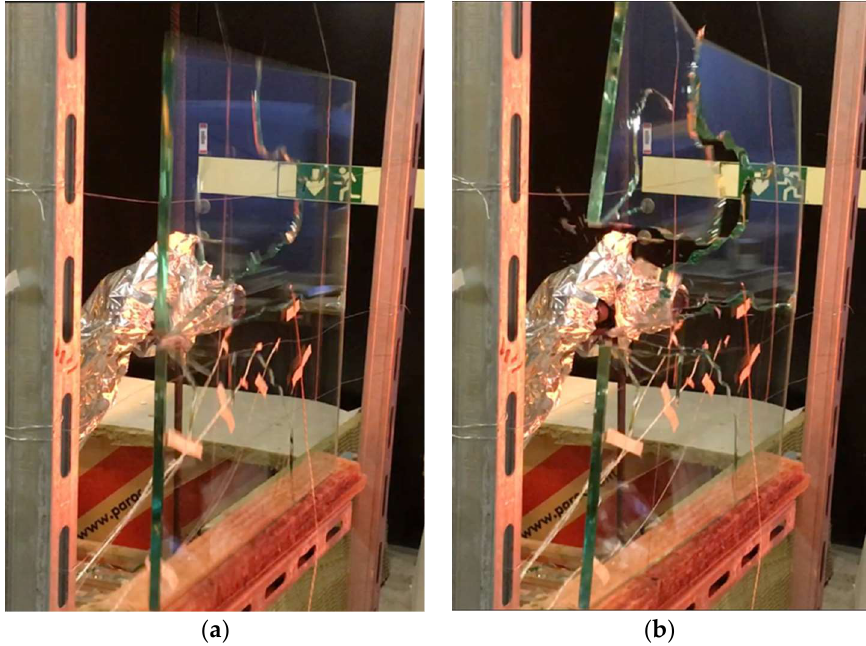
Figure 5. Specimen (Test #2) during testing: ( a ) initiation of a crack at the vertical edge; ( b ) failure of the specimen, characteristic curved thermal cracks can be noticed.